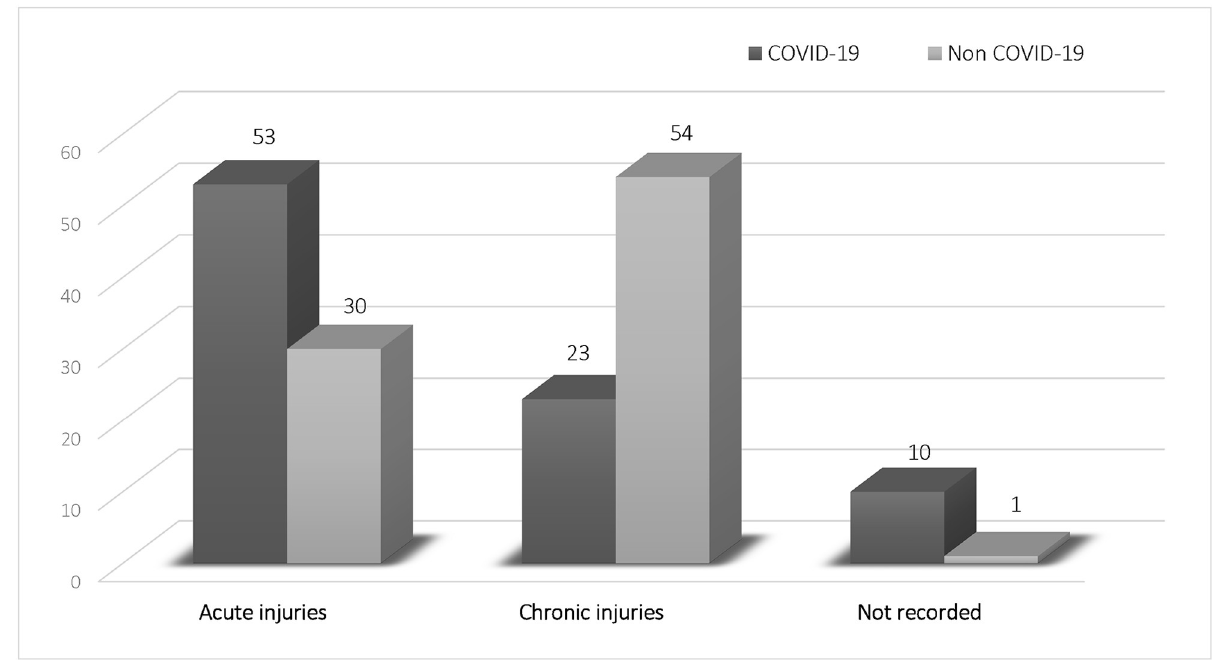
Fig 2. Acute vs. chronic PI episodes in COVID-19 and non-COVID-19 patients.